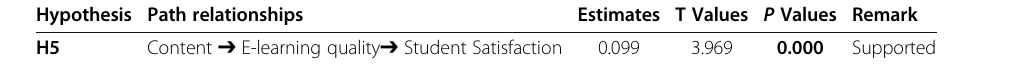
Table 7 Mediation effect Hypothesis Path